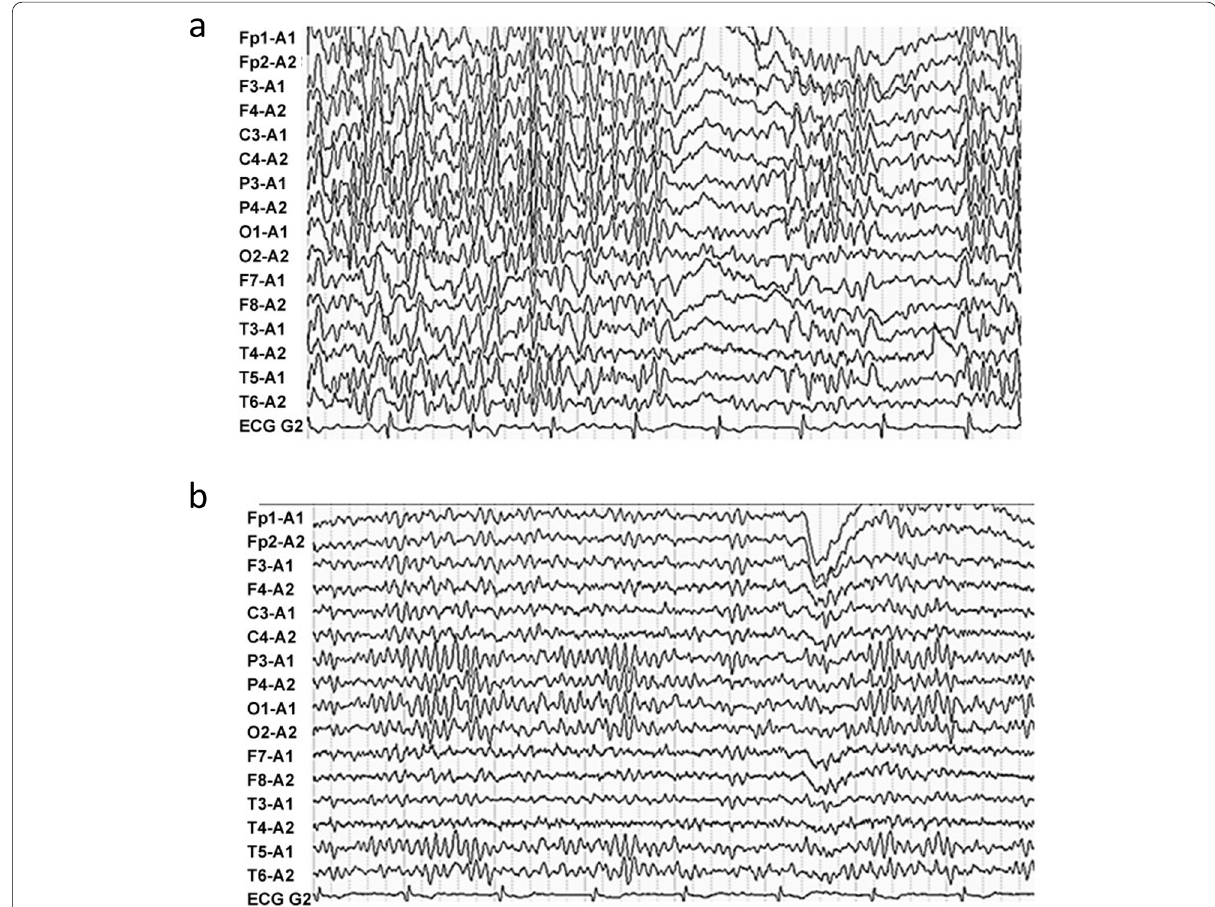
Fig. 2 EEG recordings of case 2. a Generalized 4- to 7-Hz spike-and-wave complex and spikes during behaviors associated with slow reaction, reduced speech and clouding of consciousness. b The symptoms disappeared and EEG pattern resolved after